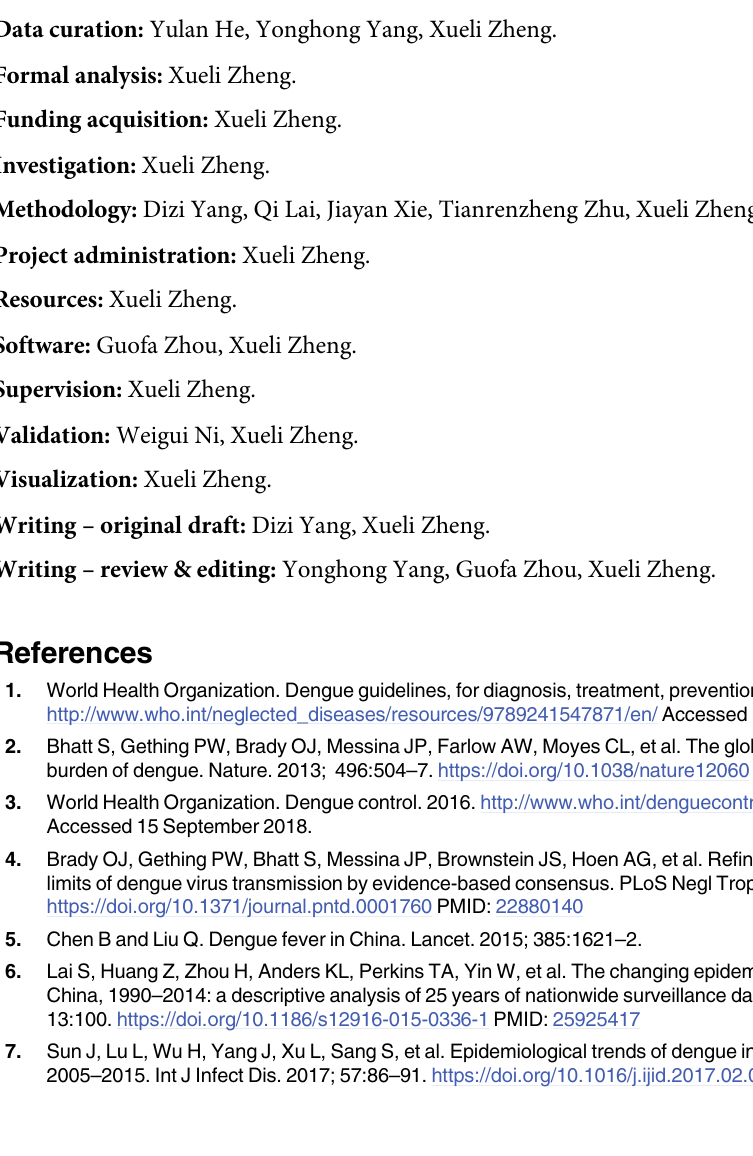
S1 Table. Larval life table summary. S2 Table. Adult’s life table summary. S3 Table. Adult’s life table